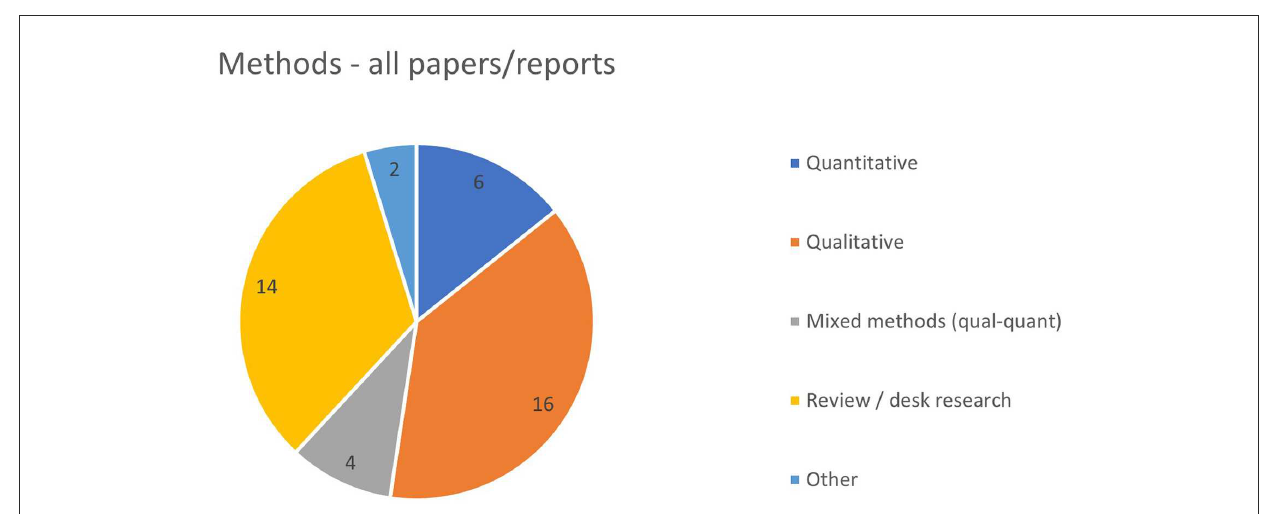
FIGURE2 Summary of methods of all papers and